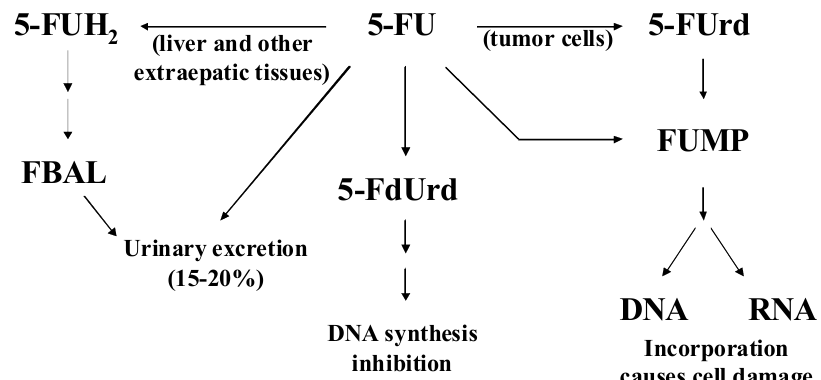
, 5-fluoro-5,6-dihydrouracil; 5-FUrd, 5- 2